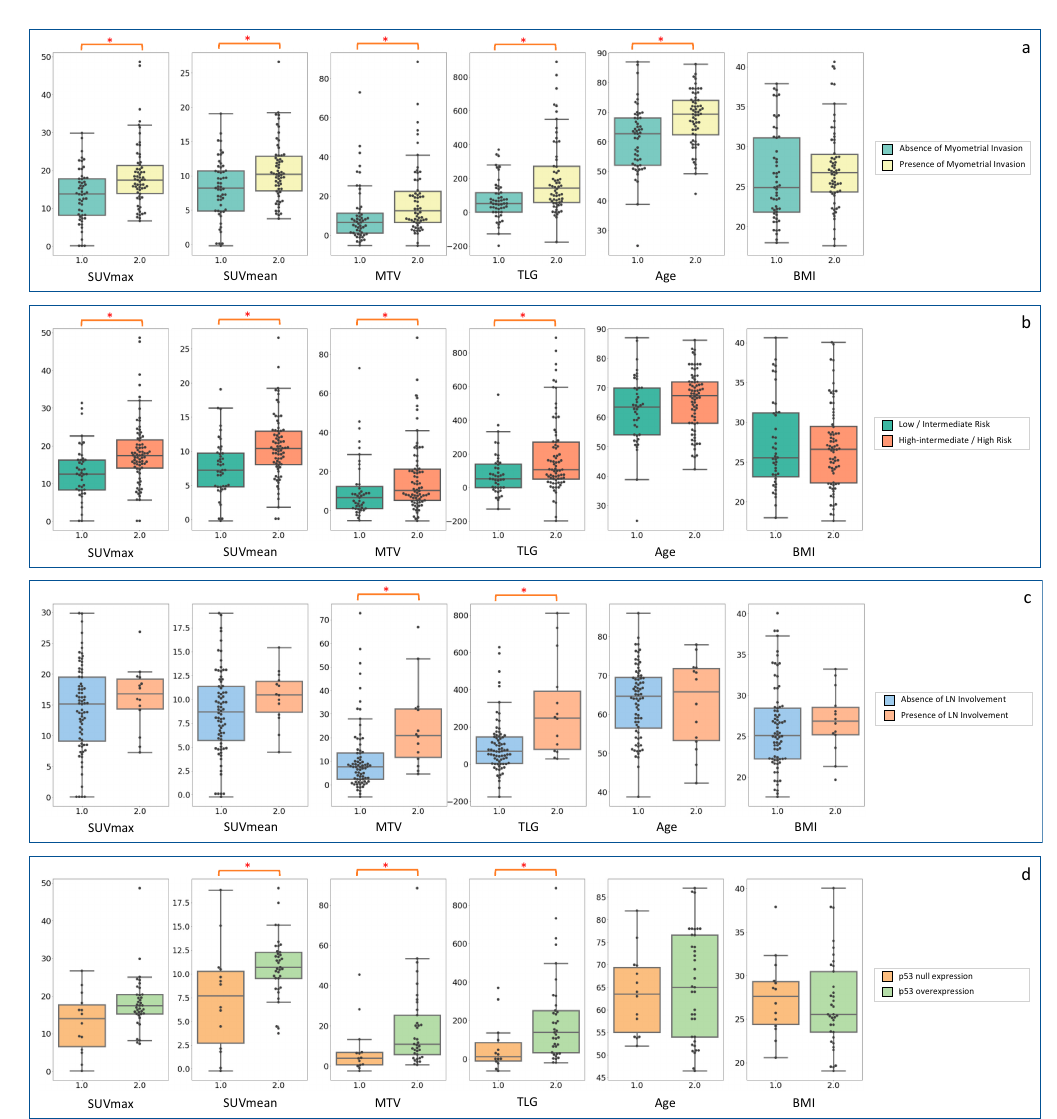
Figure 1. Distributions of 18 F-FDG PET and clinical parameters’ values with respect to the different features of EC aggressiveness. Boxplots represent parameter’s distribution according to: ( a ) presence of deep myometrial invasion (> 50%); ( b ) risk group classification; ( c ) presence of lymph nodes (LN) involvement; ( d ) p53 expression. Differences that are statistically significant (Mann-Whitney U test’s adjusted p -value < 0.05) are marked with a red *. SUV = standardized uptake value; MTV = metabolic tumour volume; TLG = total lesion glycolysis; BMI = body mass index.